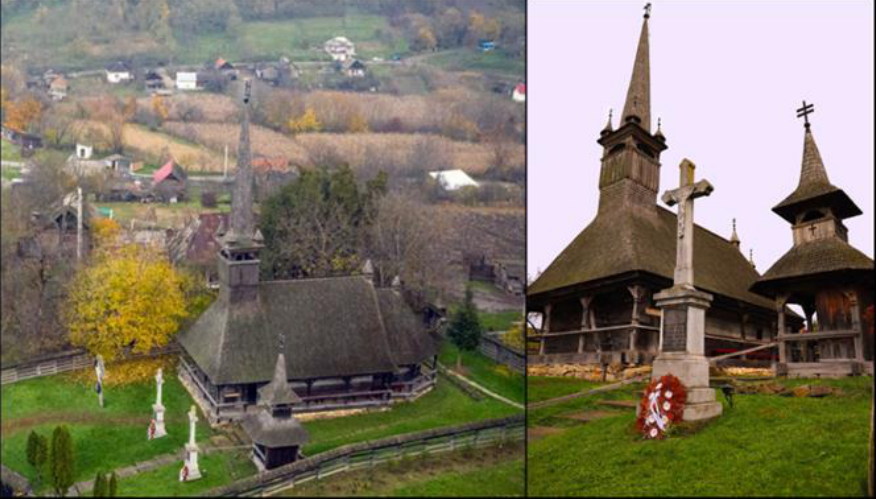
Figure 2. Overview of the exterior of the monument.